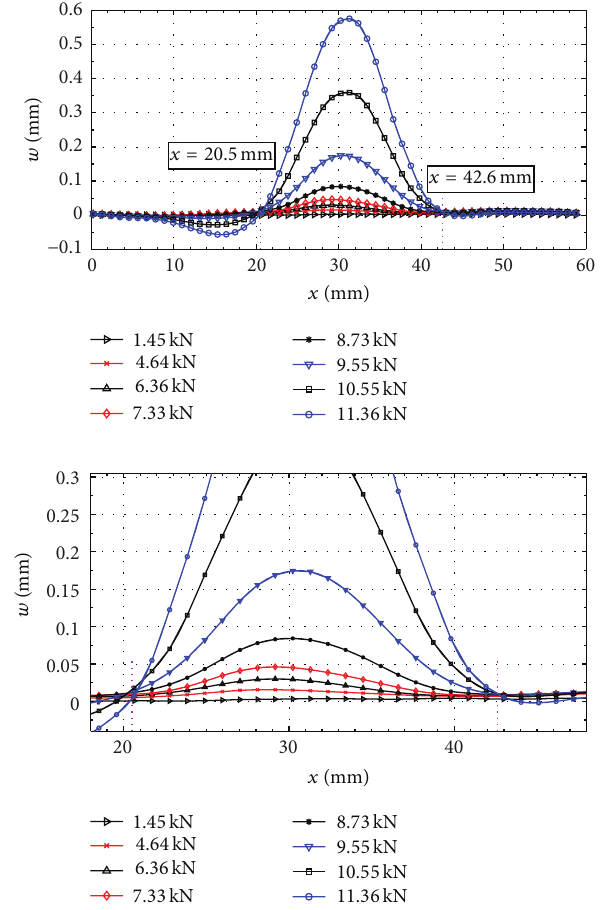
Figure6:Out-of-planedisplacementdistributionofline 𝐿 1 withthe change of compressive